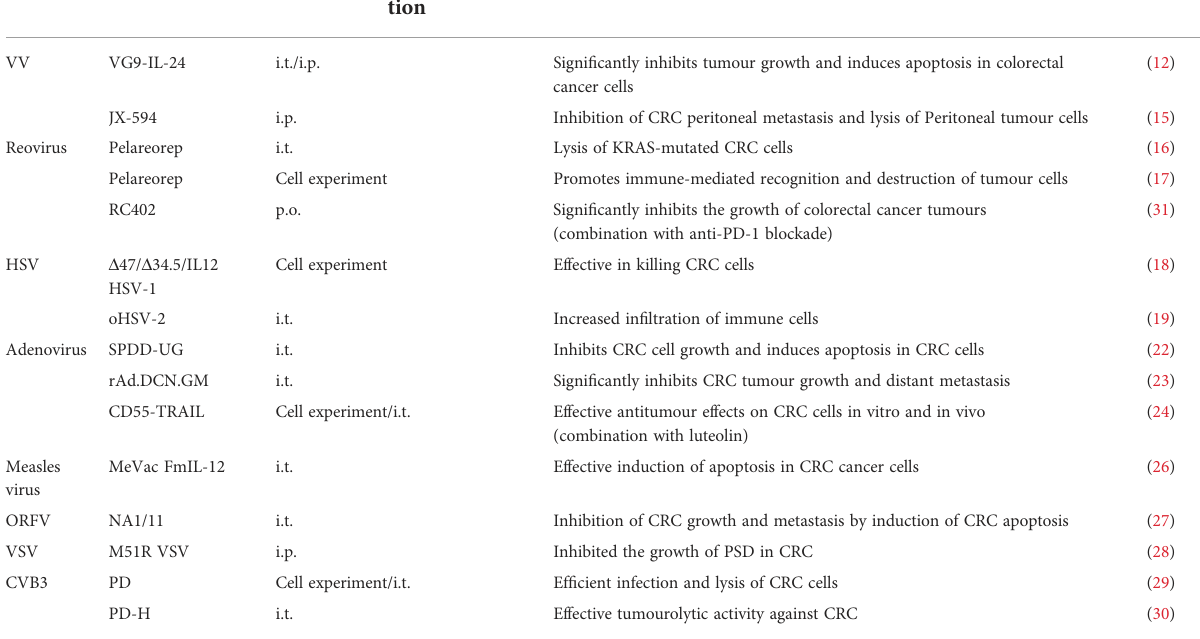
TABLE 1 Oncolytic virus available for colorectal cancer treatment.